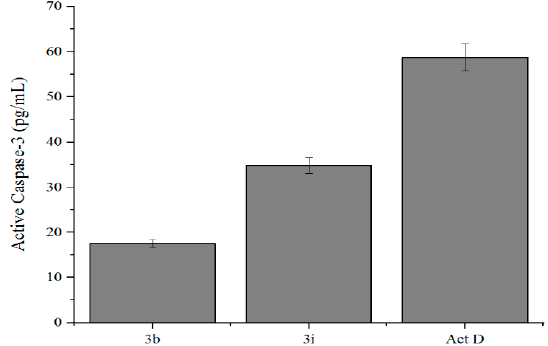
Figure 5. Effects of compounds 3b , 3i , and actinomycin D (Act. D) at 1 μ M on human Caspase-3 (Asp175) activity in MCF-7 cells, respectively.